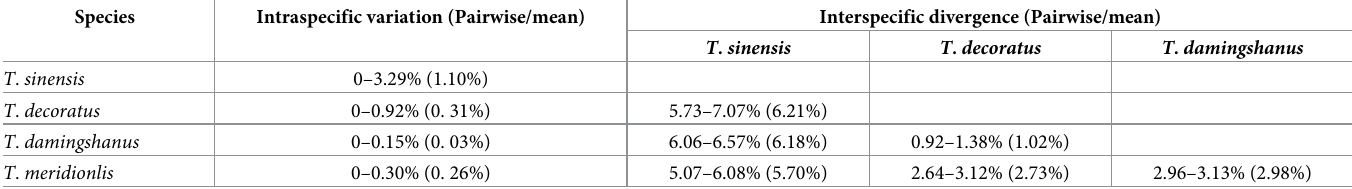
Table 2. Intraspecific variation of and interspecific divergence between species of the genus Tonkinacris calculated from COI sequences. Species